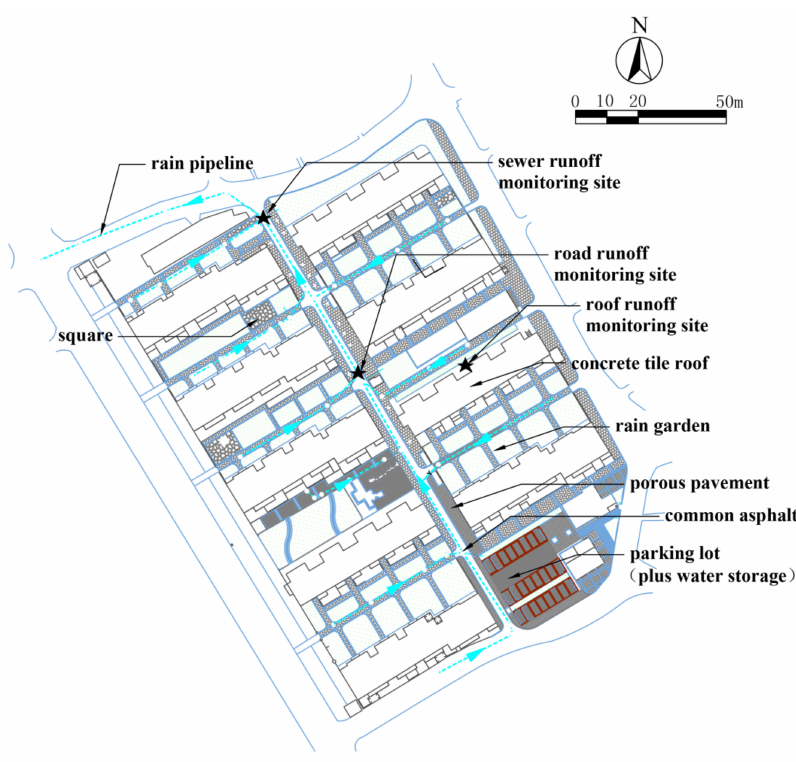
Figure 2. LID drainage unit (1.85 ha; roof and road runoff systems were collected by rain gardens and the discharge water when overflow through LID facilities occurred eventually drained into the corresponding sewer inlet nodes). Table 1. Comparison of the composition and proportion of land uses between a paired LID (bio-filtration) and conventional (piped) drainage units (LDU and CDU). CDU LDU Land Use Area (m 2 ) Percentage